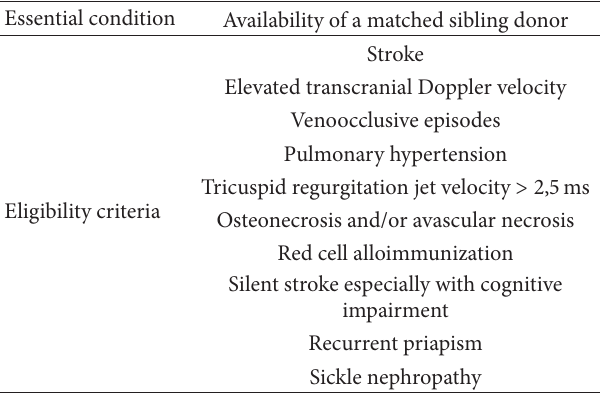
Table 1: Eligibility criteria for hematopoietic stem cell transplanta- tion (HSCT) in sickle cell disease (SCD)